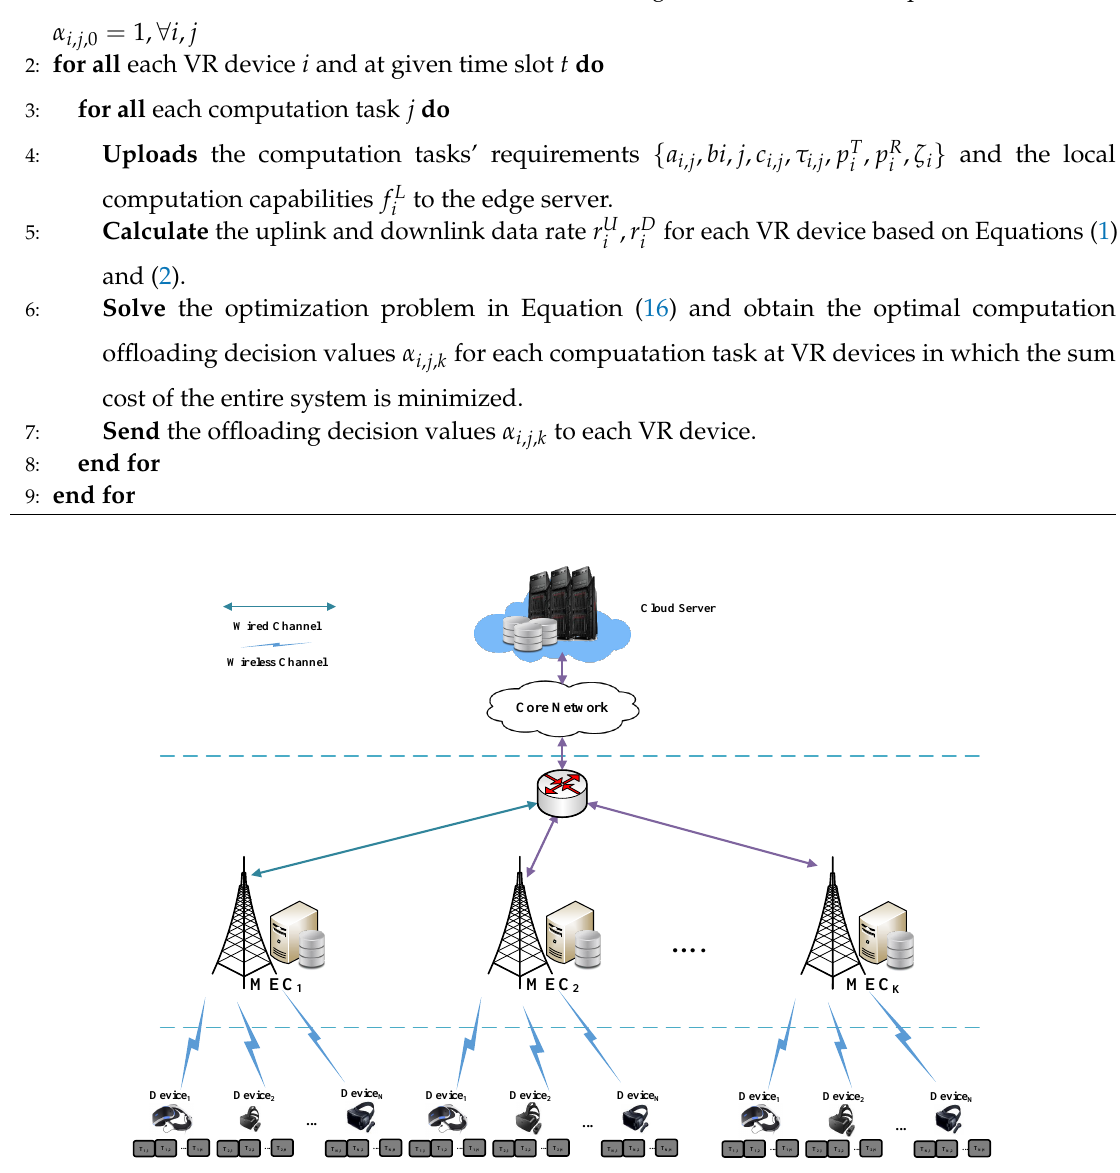
Figure 3. Multi-level, multi-edge, multi-user, with multi-task